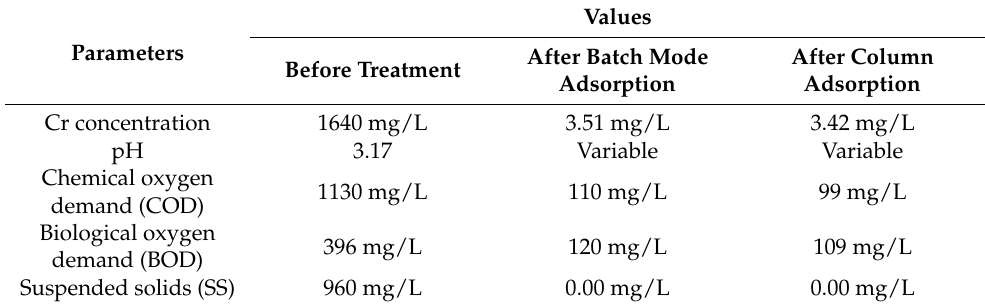
Table 8. Physicochemical characteristics of tannery wastewater before and after adsorption treatment.